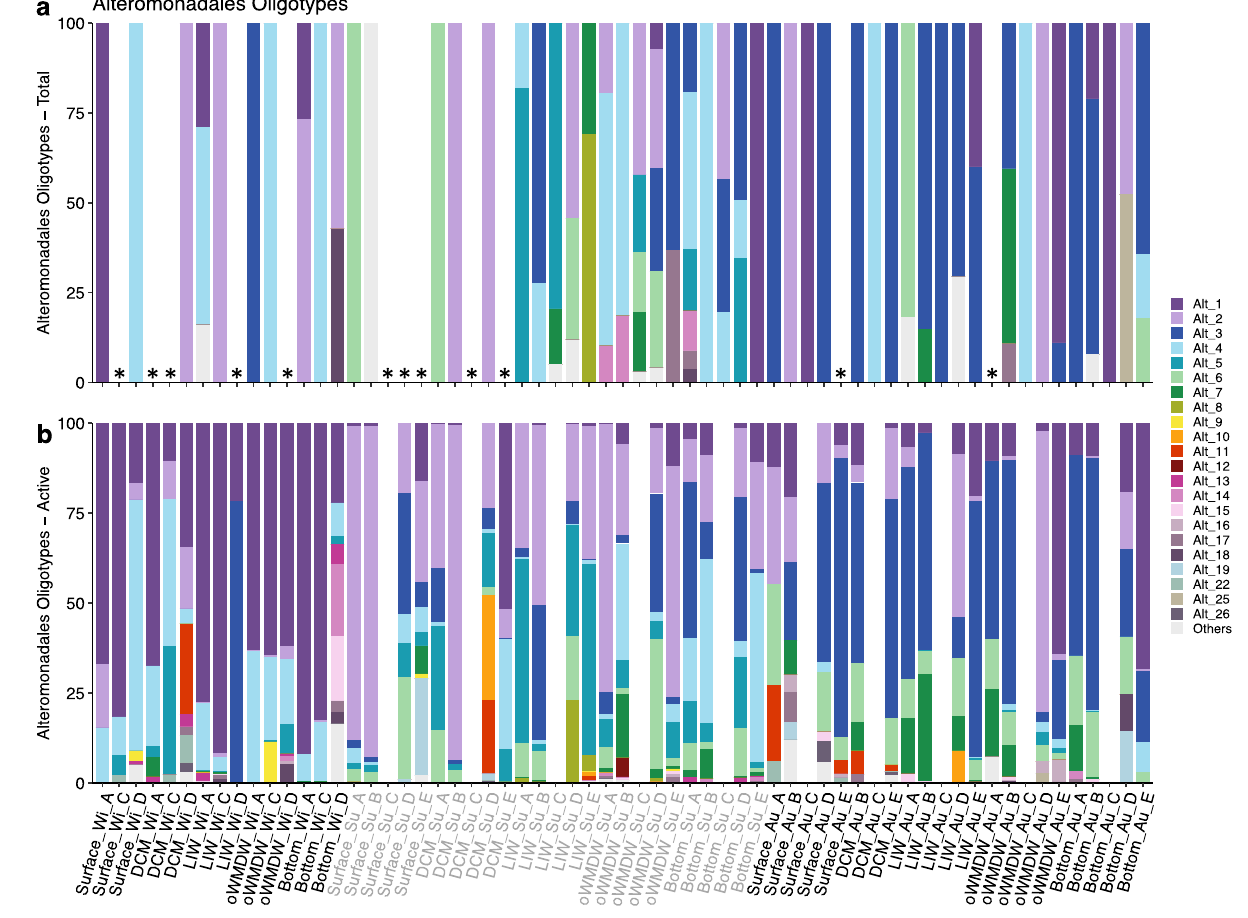
Figure 6. Oligotypes composition of Alteromonadales phylotype for ( a ) total and ( b ) actively dividing communities. Stacked bar plots represent the relative abundance of oligotypes in the different samples, ordered by season and labelled as Depth_Season_Station. Legend indicates phylotype_oligotype number. Oligotypes occurring in less than four samples are combined in ‘Others’ group. White gaps indicate samples not available or with no oligotype found (indicated by an asterisk). DCM: deep chlorophyll maximum; LIW: Levantine intermediate water; oWMDW: old western Mediterranean deep water; Wi: winter; Su: summer; Au: